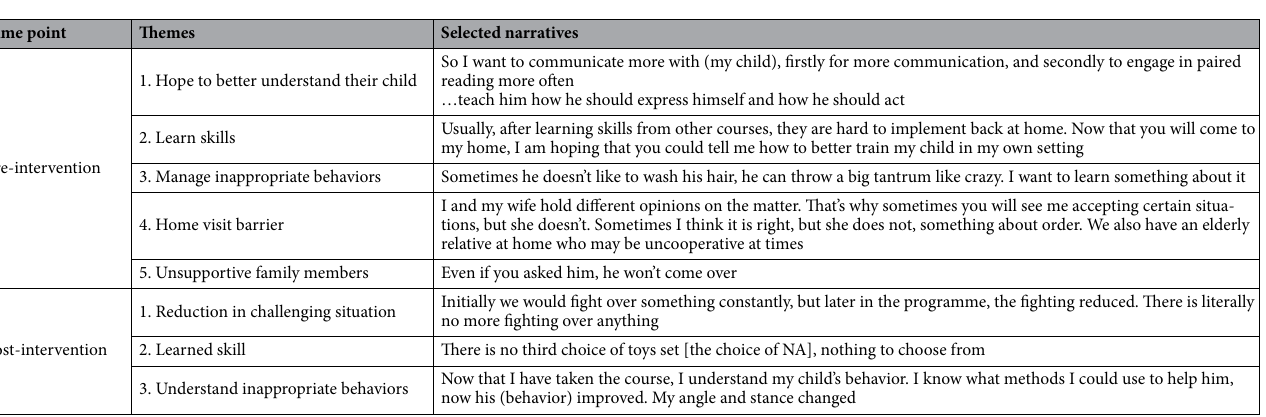
Table 5. Themes and selected narratives pre- and post-intervention focus groups with caregivers in phase